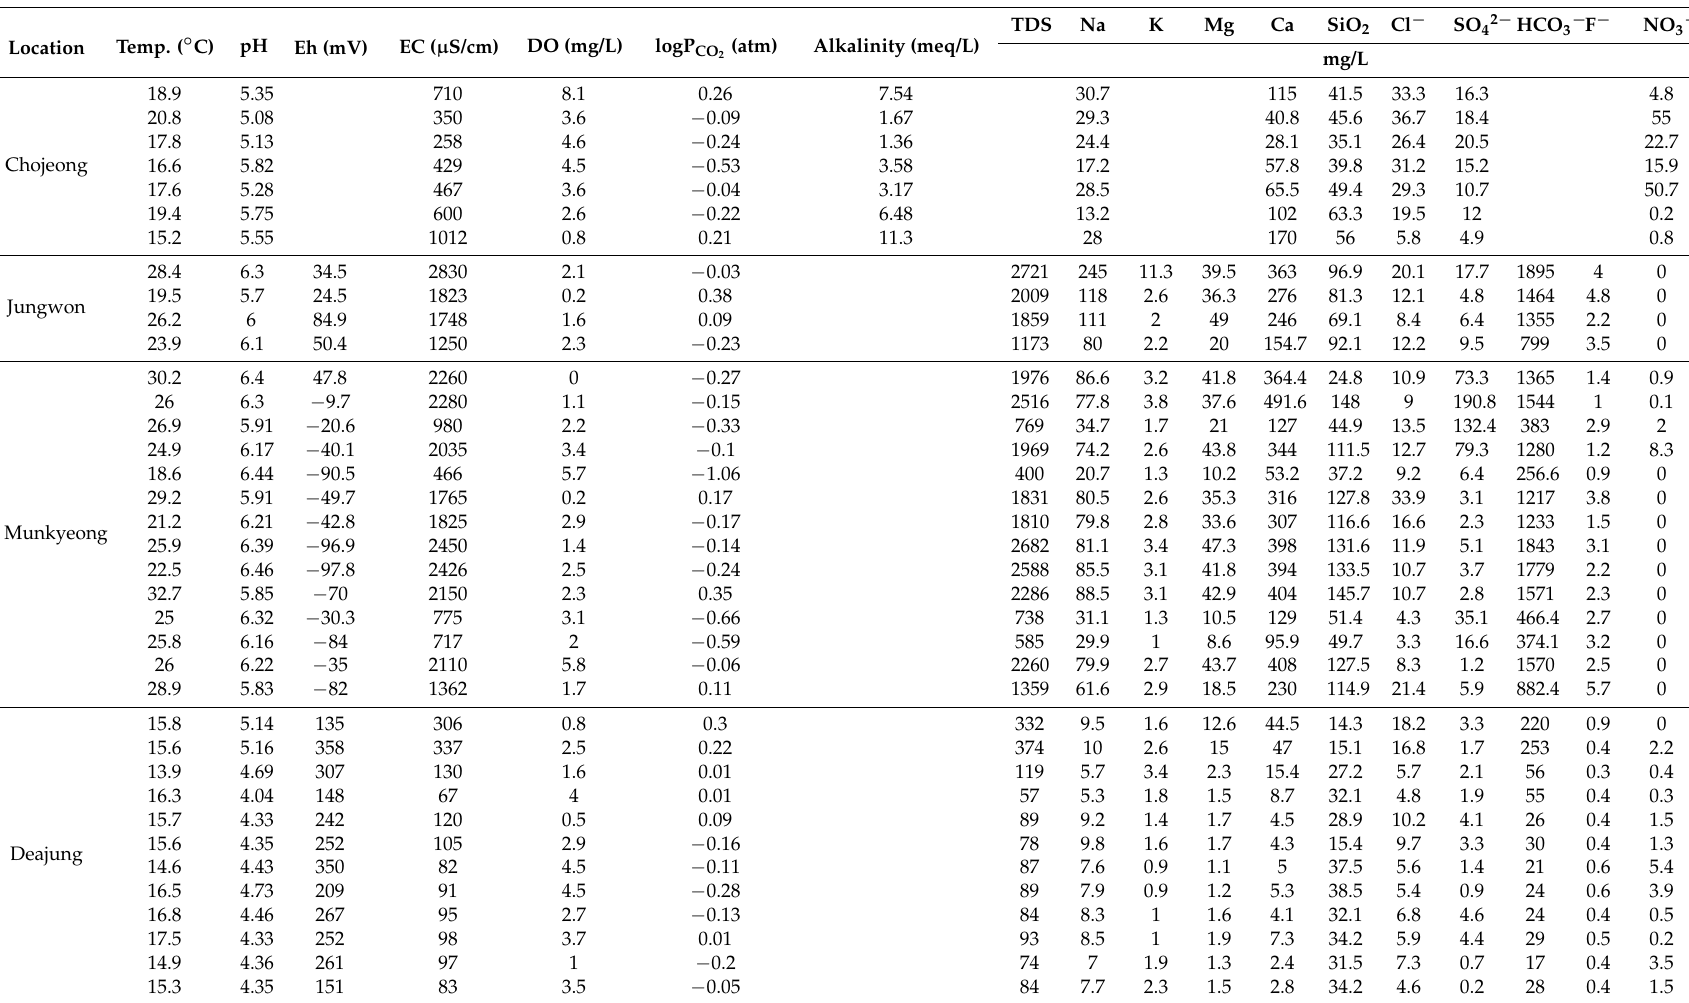
Table 10. Geochemical data of ordinary water samples from Chungcheong Province